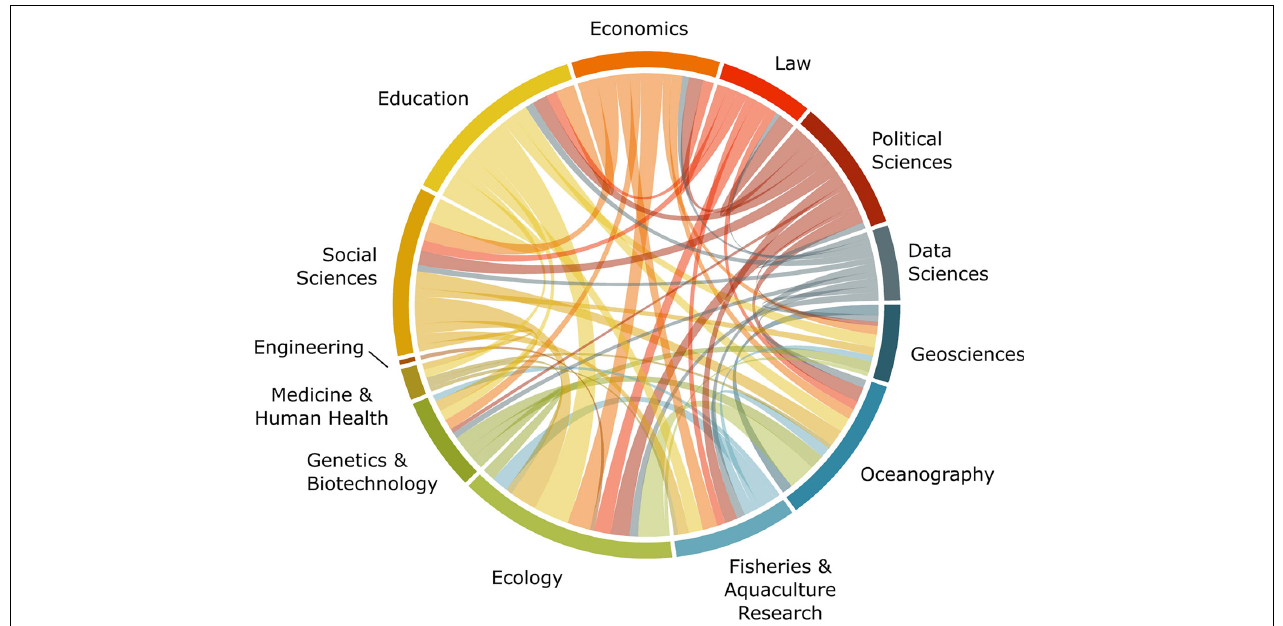
FIGURE 2 | Chord diagram visualizing the combinations of disciplines involved within investigated projects and initiatives. The thickness of the connections relates to the number of discipline combinations stated explicitly in the questionnaire.